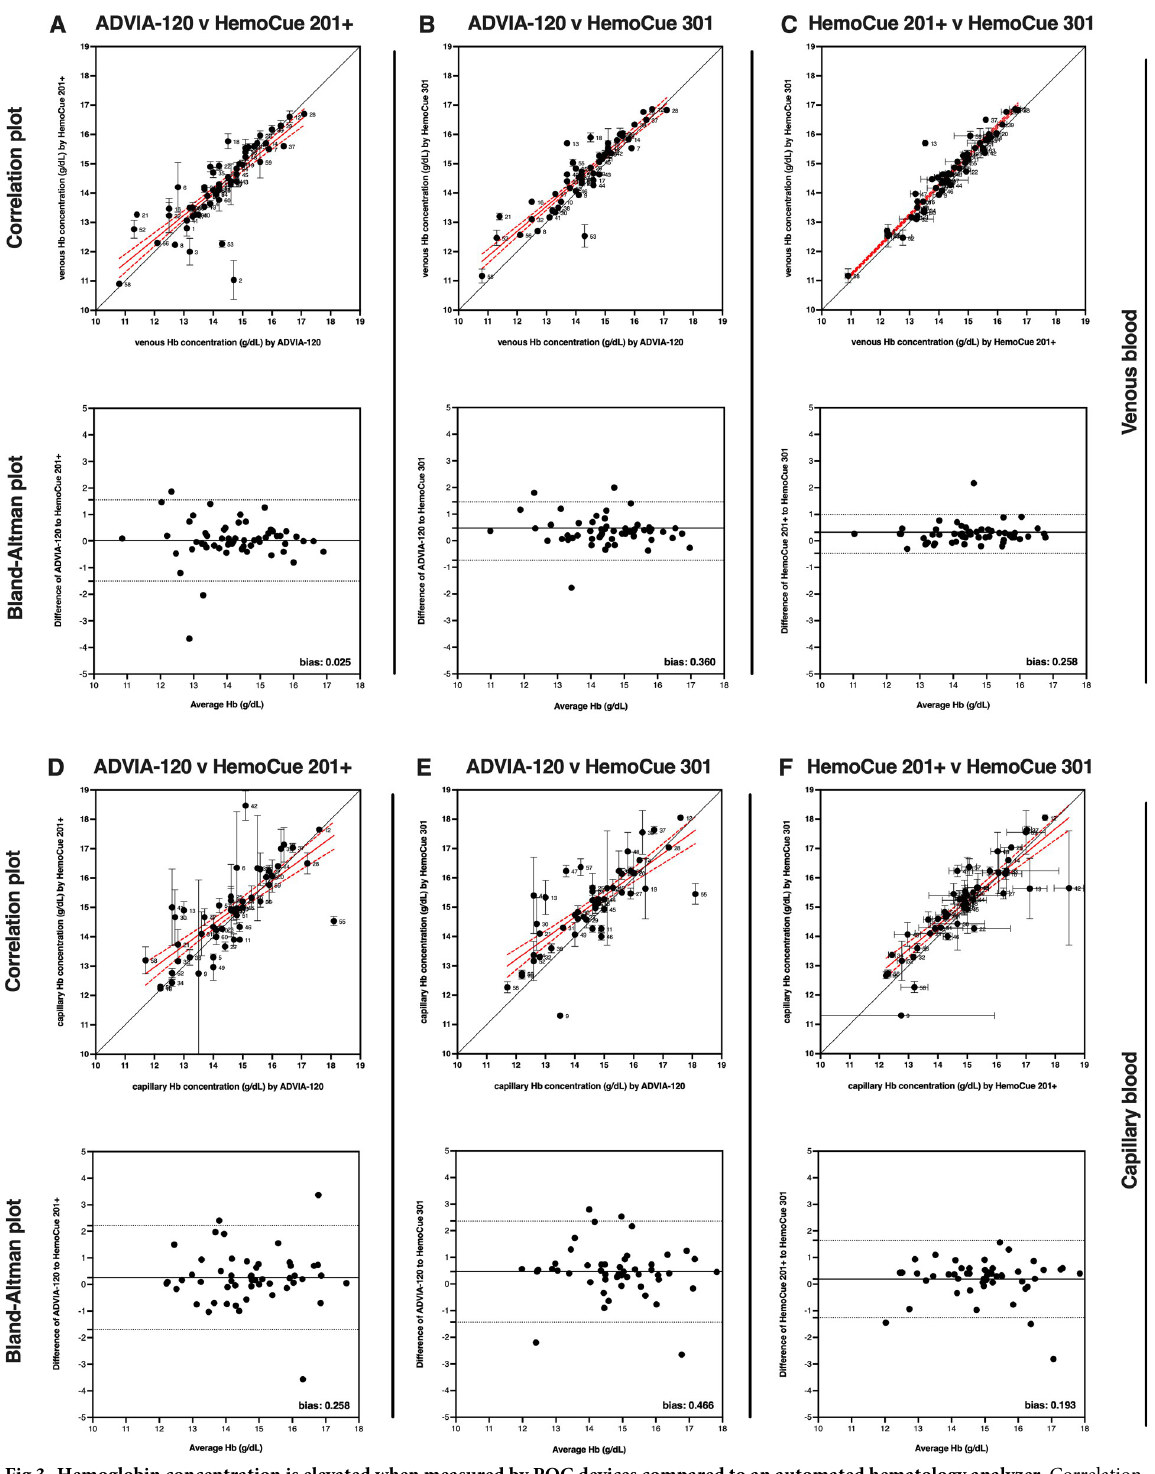
Fig 3. Hemoglobin concentration is elevated when measured by POC devices compared to an automated hematology analyzer. Correlation and Bland-Altman plots comparing venous Hb values measured by ( A ) ADVIA-2120 and HemoCue 201+, ( B ) ADVIA-2120 and HemoCue 301, and ( C ) HemoCue 201+ and HemoCue 301 and comparing capillary Hb values measured by ( D ) ADVIA-2120 and HemoCue 201+, ( E ) ADVIA-2120 and HemoCue 301, and ( F ) HemoCue 201+ and HemoCue 301. The correlation plots show the capillary and venous Hb values (mean ± SEM) proximity to line of concordance (solid black line), as well as linear regression (solid red line) ± 95% confidence interval (red